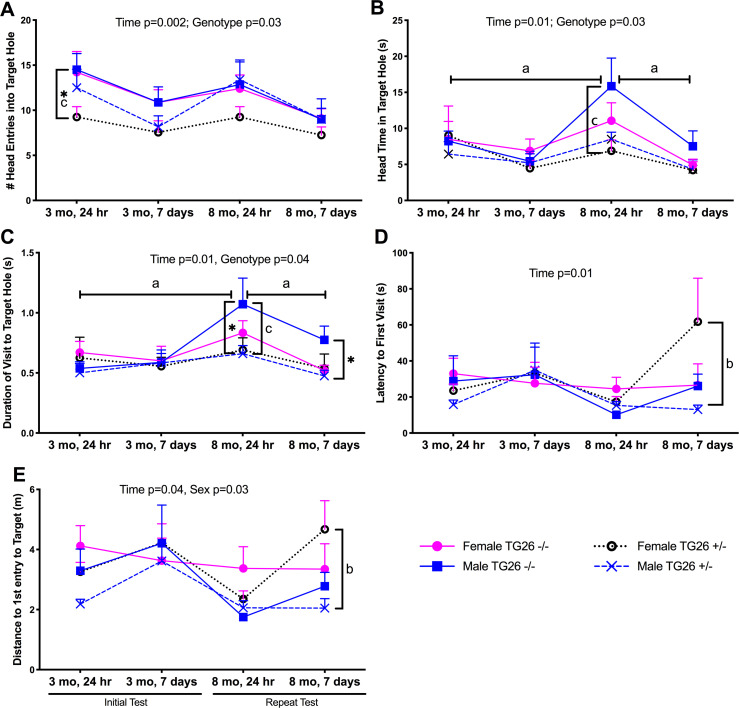
Barnes maze target hole results.Assessment of memory abilities on a Barnes maze during target hole analyses at 3 and 8 months of age, at two retention probe test points (24 hours and 7 days after completion of acquisition training, which are Days 5 and 12 of Barnes maze testing). (A) Mean number of head entries into the target hole. (B) Mean head time at target hole in seconds (s). (C) Mean duration of each visit to target hole. (D) Mean latency of first visit to target hole. (E) Mean distance to first entrance of head into target hole in meters (m). Mean ± SEM shown. *: p<0.05, compared to wild type -/- mice of same sex; a<0.05, compared to values obtained for these same animals at the other time points indicated; b: p<0.05, compared to opposite sex of same genotype (opposite sex); c: p<0.05, compared to opposite sex of opposite genotype (opposite sex and genotype). Numbers/group as indicated in Fig 6.